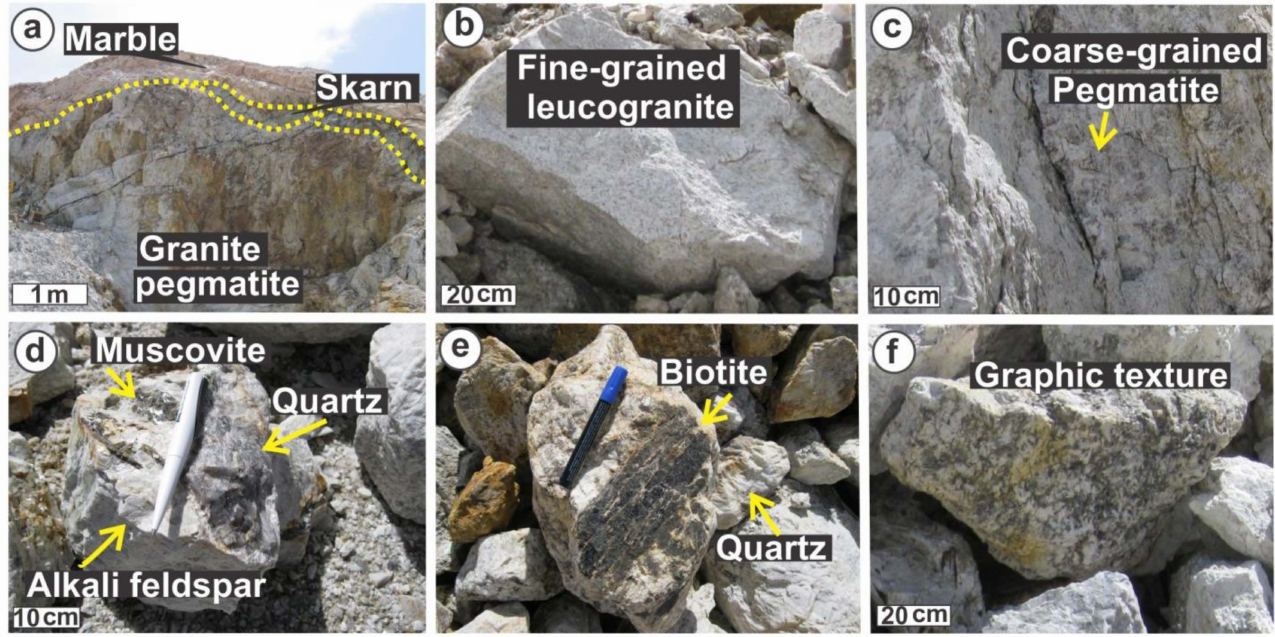
Figure 3. Photographs of the Ebrahim-Attar granitic pegmatite. ( a ) This pluton intruded into the Jurassic marble in the study area. ( b , c ) Size variation from the border (fine-grained) to the inner pegmatitic part (coarse-grained). ( d , e ) Megacrystals of the main mineral in the inner pegmatitic part, including large feldspar and muscovite, quartz, and less biotite. ( f ) Naked-eye graphic